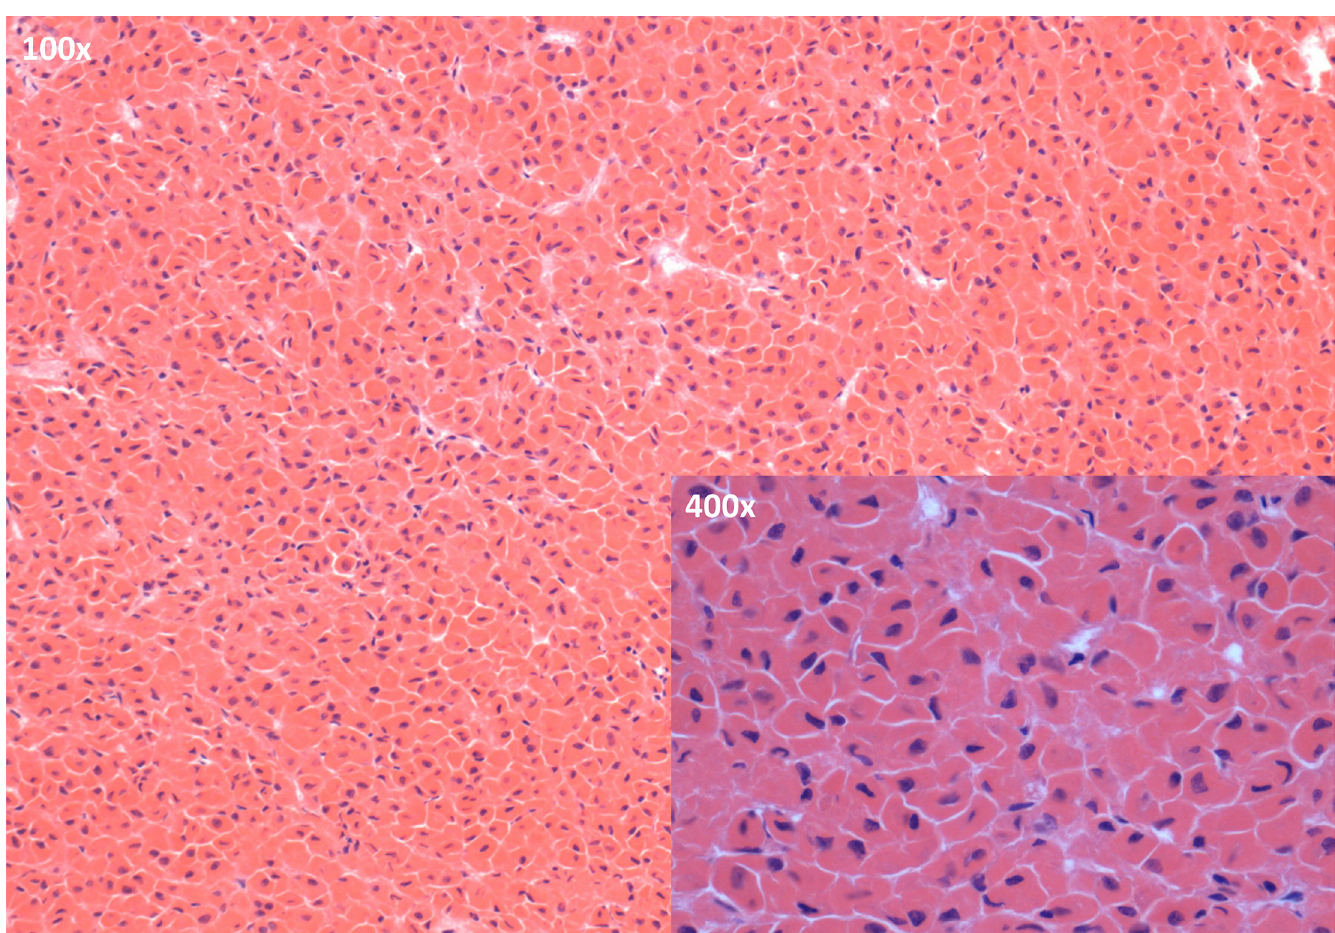
Fig 7. Microscopic image of the anterior pituitary of a diabetic cat with confirmed HS. A clear predominance of acidophils is apparent in the sections of the pars distalis of the anterior pituitary (H&E staining; main image: objective 100x; inset: objective: